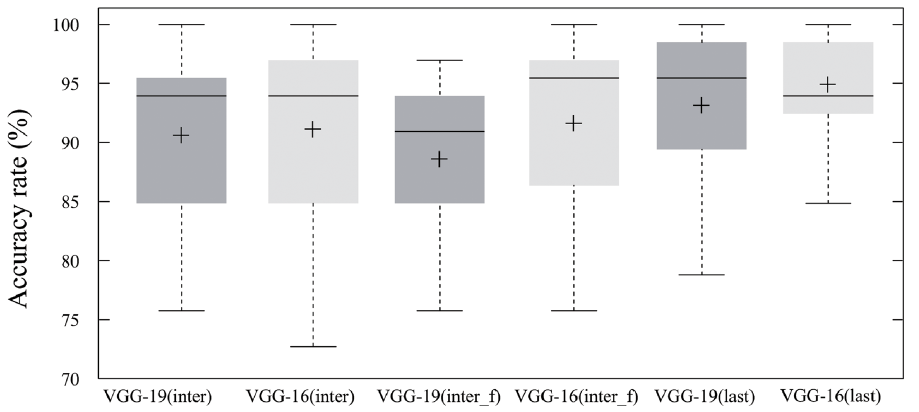
Fig 4. Accuracy of the proposed model with different pre-trained CNNs. Average recognition rates of the proposed model: VGG-19(intermediate): 90.40%; VGG-16(intermediate): 90.90%; VGG-19(fine-tuned intermediate): 88.38%; VGG-16(fine-tuned intermediate): 91.41%;VGG-19(last): 92.92%; VGG-16(last): 94.69%.